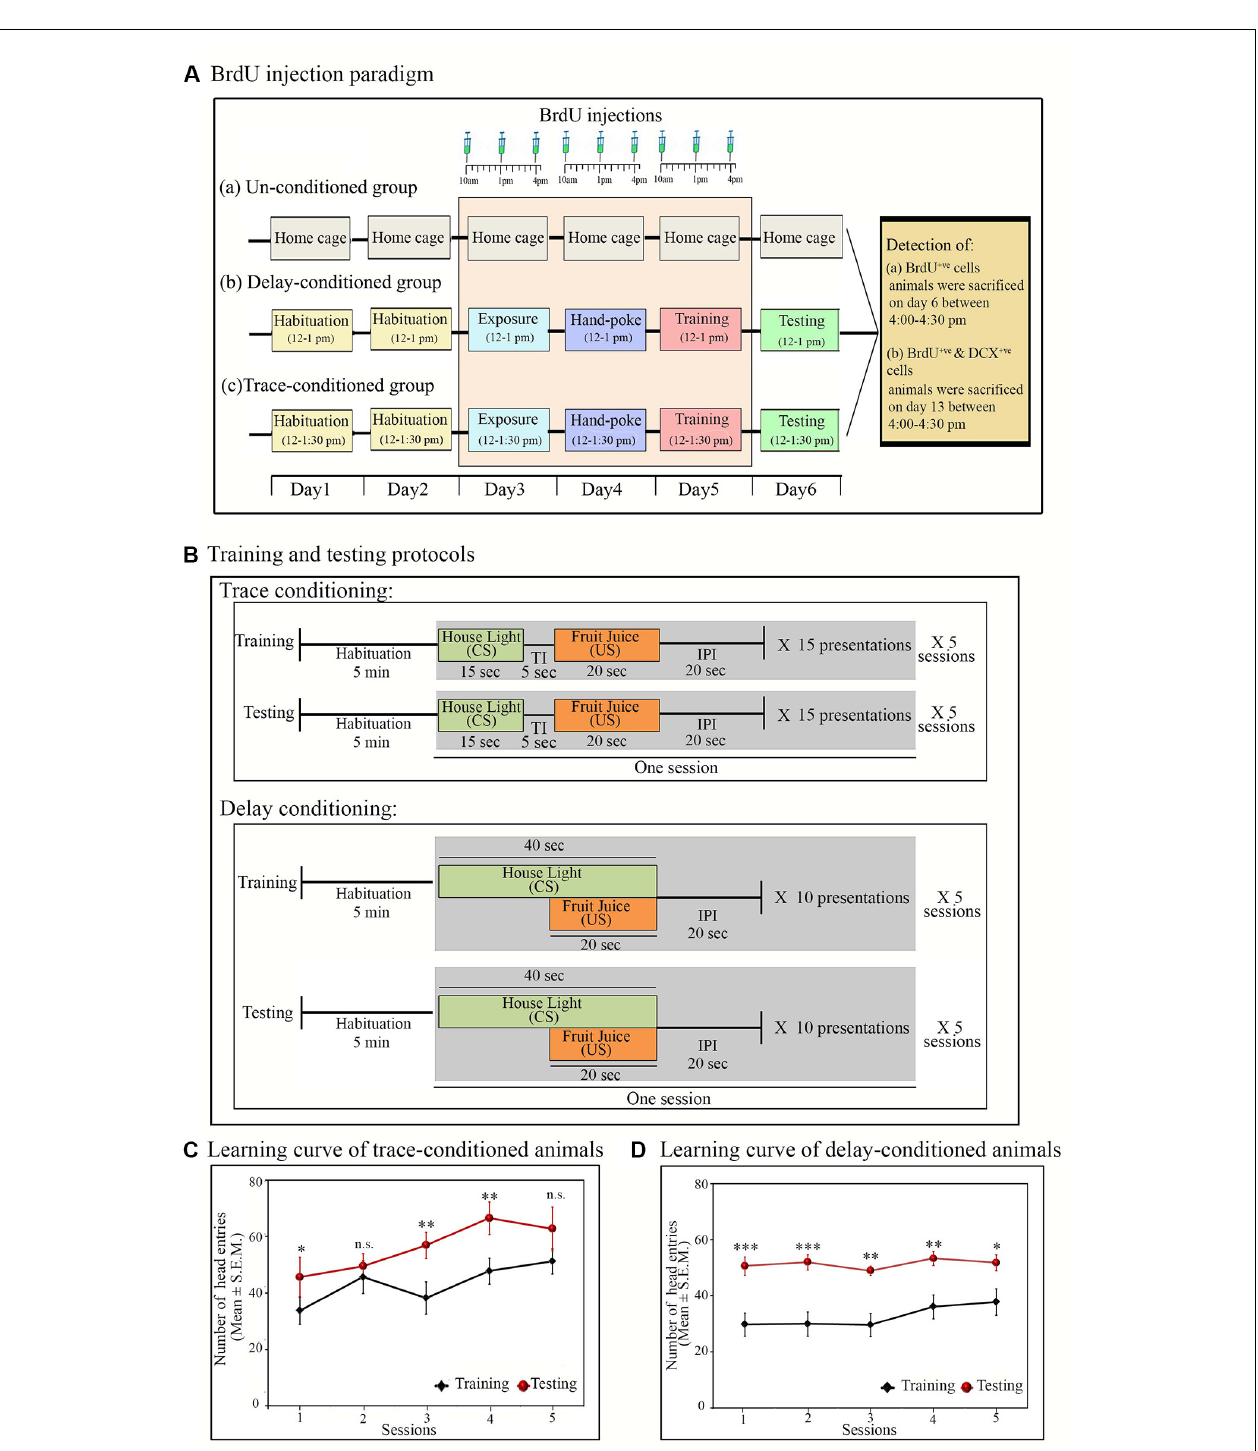
FIGURE 1 | Experimental protocols: (A) time and days of BrdU (100 mg/kg) injection in (a) un-conditioned, (b) delay-conditioned and (c) trace-conditioned groups. BrdU was injected three times a day at an interval of 3 h, for three consecutive days (from day 3 to day 5) in all groups. In the conditioned groups: the first injection was given 2 h before the exposure/training, the second injection was given immediately after the completion of exposure/training, and the third injection was given 3 h after the exposure/training. In un-conditioned controls, no training was performed, but BrdU injection was given at the time-matched hours. Conditioned animals were tested for their learned tasks the next day at the same time and sacrificed 3 h after the testing. un-conditioned animals were sacrificed at the time matched hours of trace/delay conditioned animals. For quantification of DCX +ve cells, the animals were sacrificed on Day 13 (7 days after appetitive-conditioned